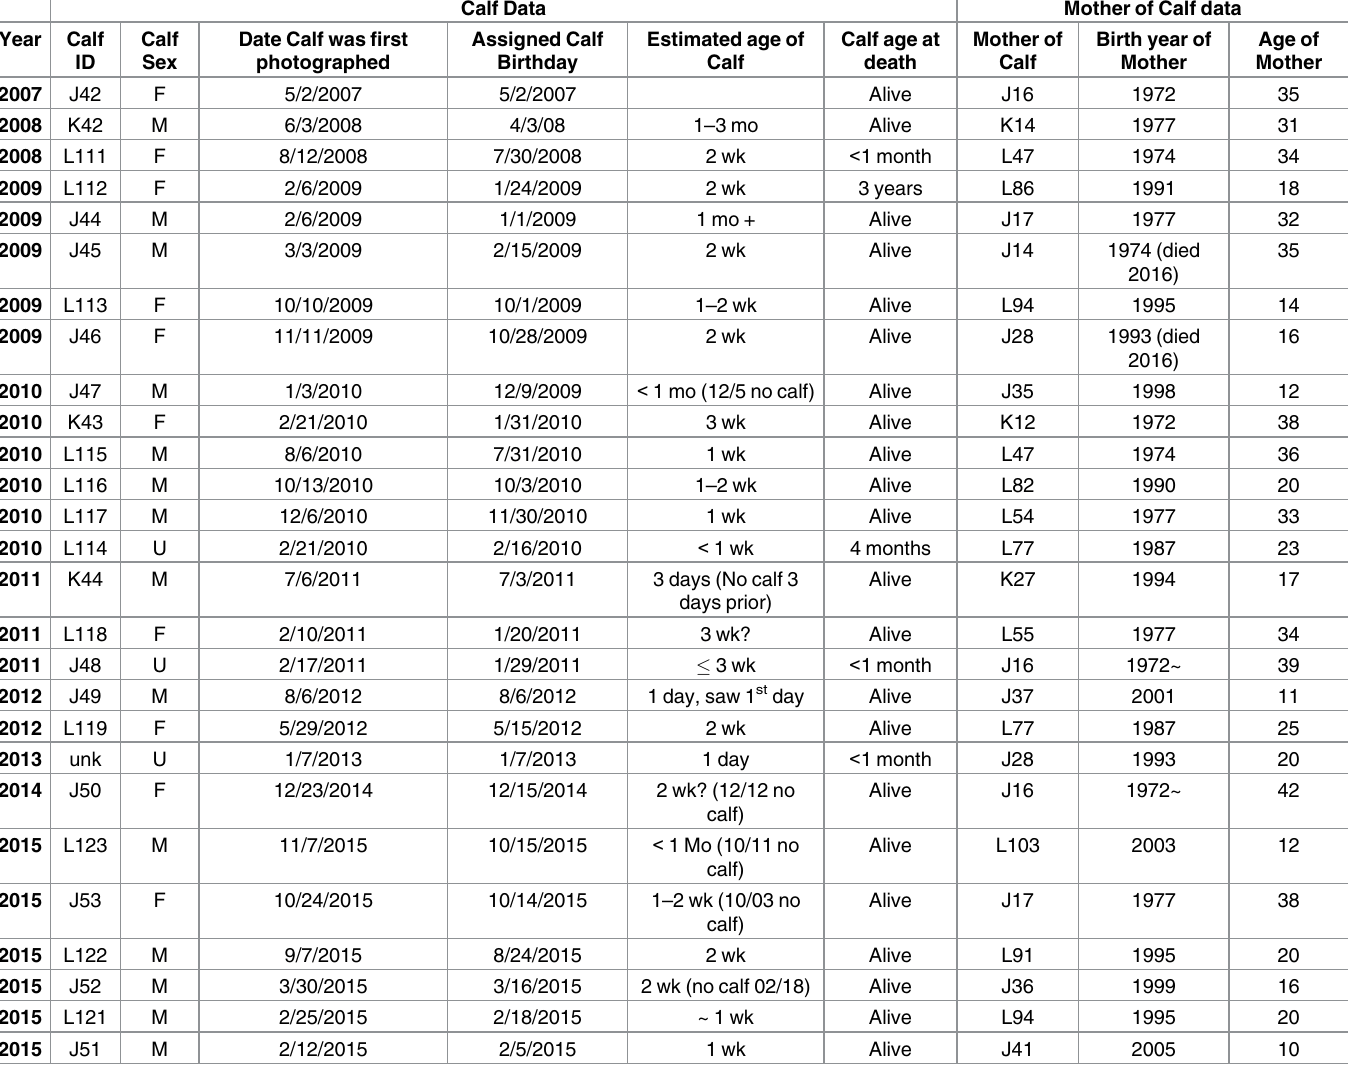
Table 1. Sex, date of first observation, estimated age, birthdate and survival status for each calf whose mother was sampled during her pregnancy or lactation of that calf. Calf Data Mother of Calf